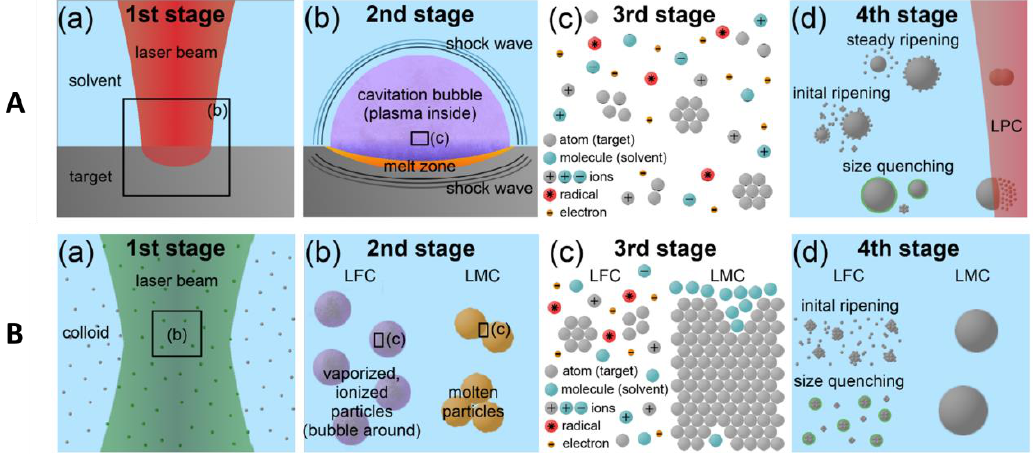
Figure 4. Laser–matter interaction stages for ( A ) laser synthesis of colloids (LSC): ( a ) laser irradiation of target, ( b ) material ablation and the formation of plasma, cavitation bubble and shock wave, ( c ) nanostructure formation, and ( d ) ripening, quenching and re-irradiation of nanostructures. ( B ) laser processing of colloids (LPC): ( a ) laser irradiation of colloidal particles, ( b ) material phase changes, ( c ) particles formation, and ( d ) ripening and quenching of produced particles. [45].